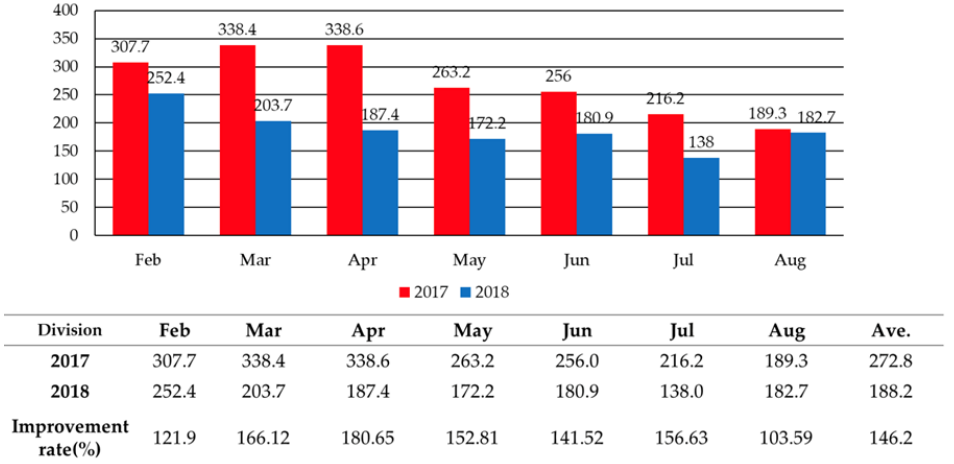
Figure 8. Monthly PM 10 concentrations in Bupyeongsamgeori station tunnel.